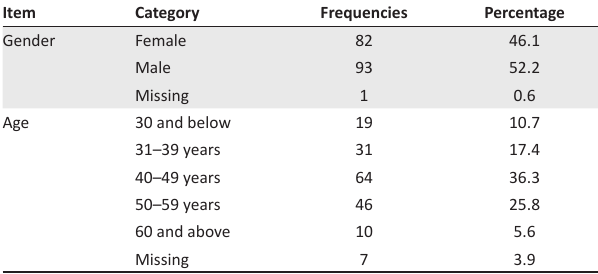
TABLE 1: Characteristics of the participants ( N =